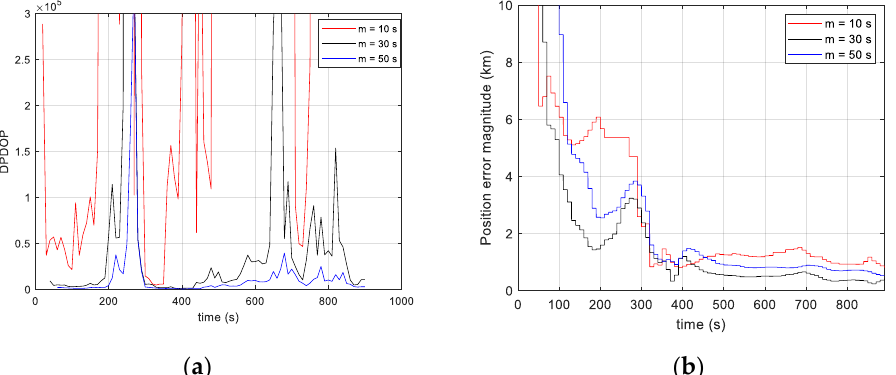
Figure 14. ( a ) Doppler position dilution of precision; ( b ) Position error magnitude. A comparison